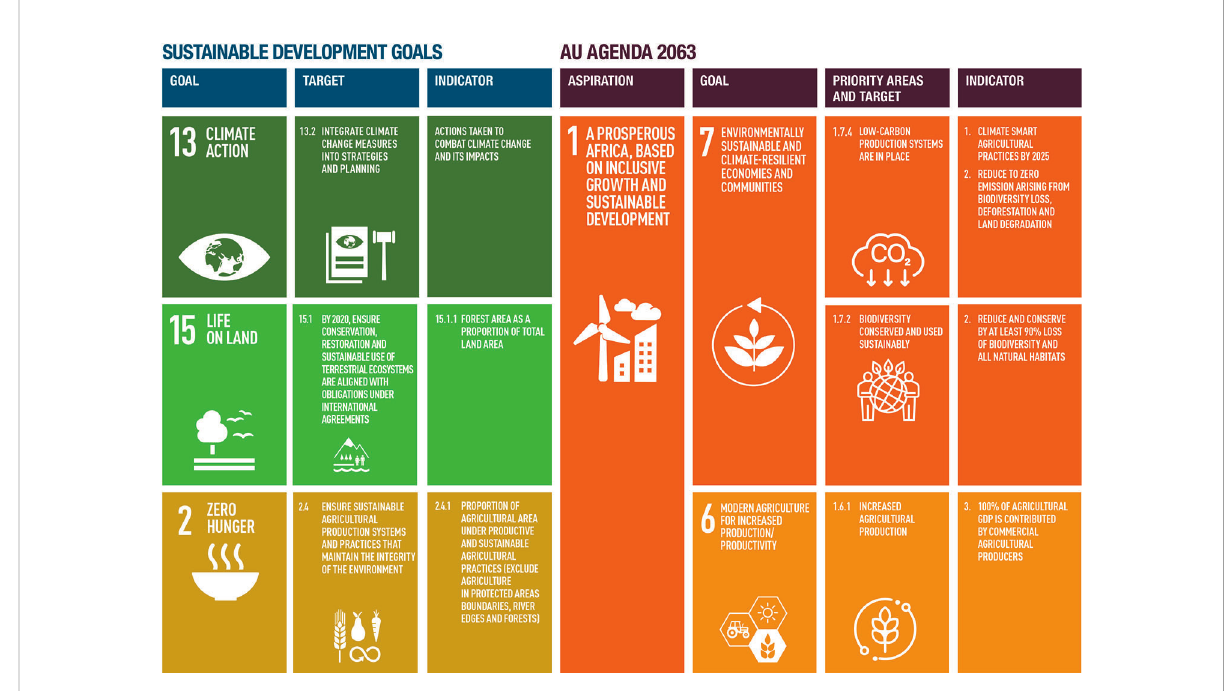
FIGURE 1 Link between the Sustainable Development Goals (SDG) targets, and indicators for 2030 (UN, 2015) and AU Agenda 2063 aspiration, goals, priority areas and targets, and indicators (AUC, 2015) used in this